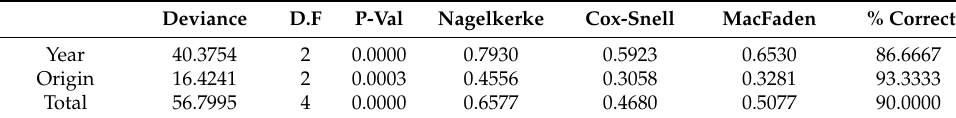
Table 3. Fit measures for each response.